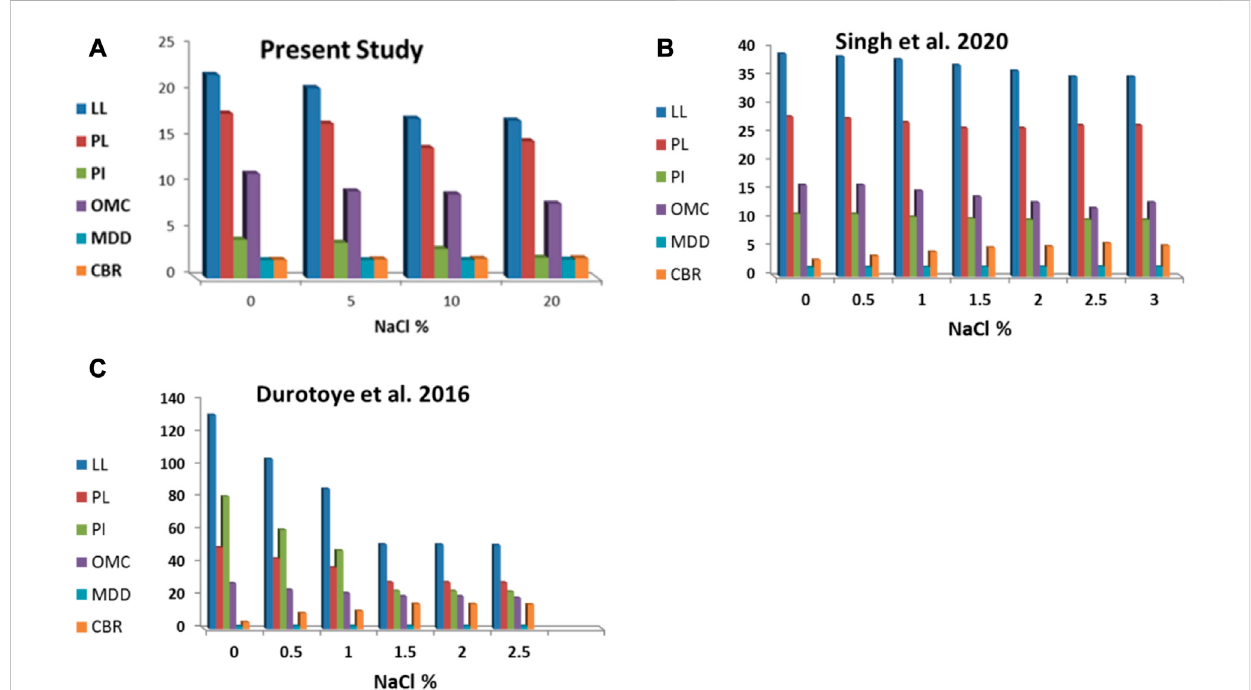
FIGURE 14 Comparisonof fi ndingswiththeexistingliteraturewithvariouspercentagesofNaCl. (A) Presentstudy, (B) Singhetal.(2020),and (C) Durotoyeetal.(2016).